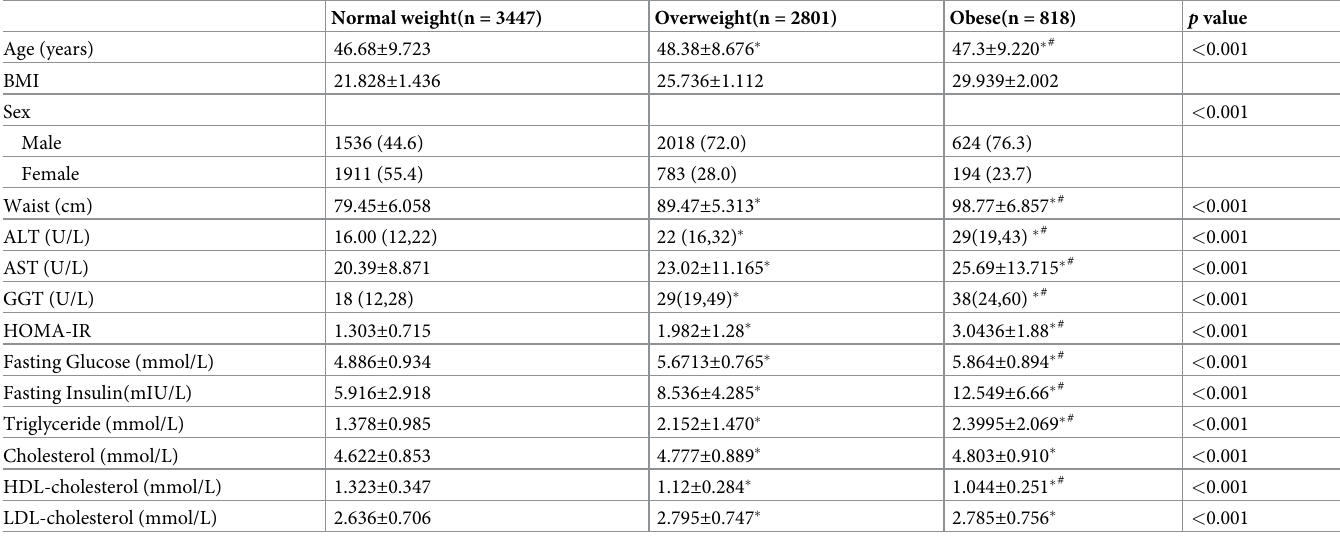
Table 1. Characteristics of subjects by weight